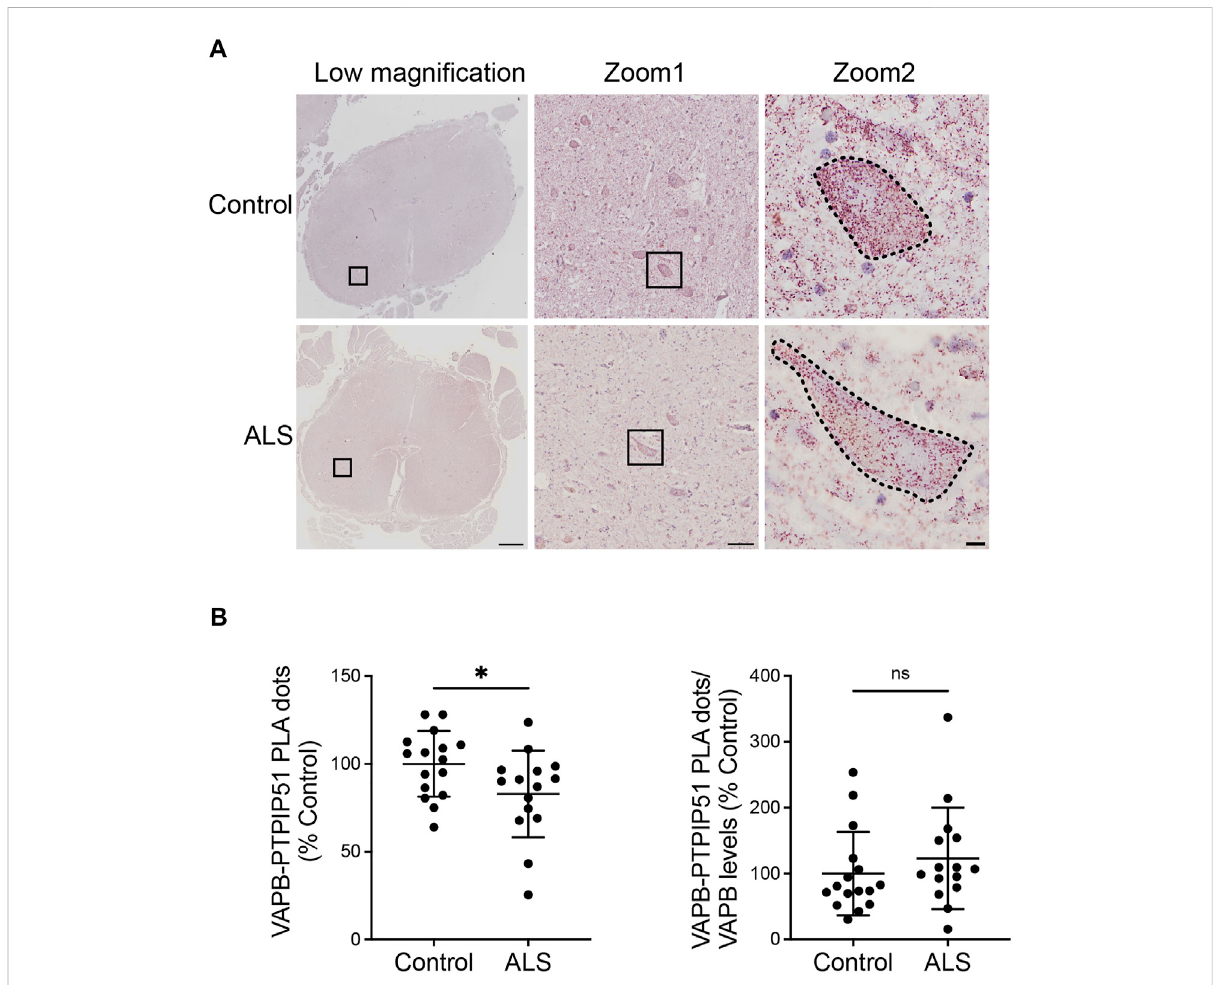
The VAPB-PTPIP51 interaction is reduced in ALS spinal cord motor neurons. (A) Representative images of VAPB-PTPIP51 PLAs in control and ALStissues.Lowmagni fi cationandtwozoomimagesareshownforeachsample;motorneuronsareoutlinedinthehighestzoomimages.Thegraph shows the mean number of VAPB-PTPIP51 PLA dots per motor neuron for each case. VAPB-PTPIP51 PLA numbers were normalised to the area of each cell so as to correct for any changes in neuron size in the ALS cases as described in Materials and Methods. (B) Graph showing mean numbersofVAPB-PTPIP51PLAdotsfollowingnormalisationtoVAPBproteinlevels.N=16controland15ALScases.Datawereanalysedbyunpaired t -test; Error bars are s. e.m., * p < 0.05, ns not signi fi cant. Scale bars; 1,000 μ m (Low magni fi cation), 100 μ m (Zoom 1) and 10 μ m (Zoom